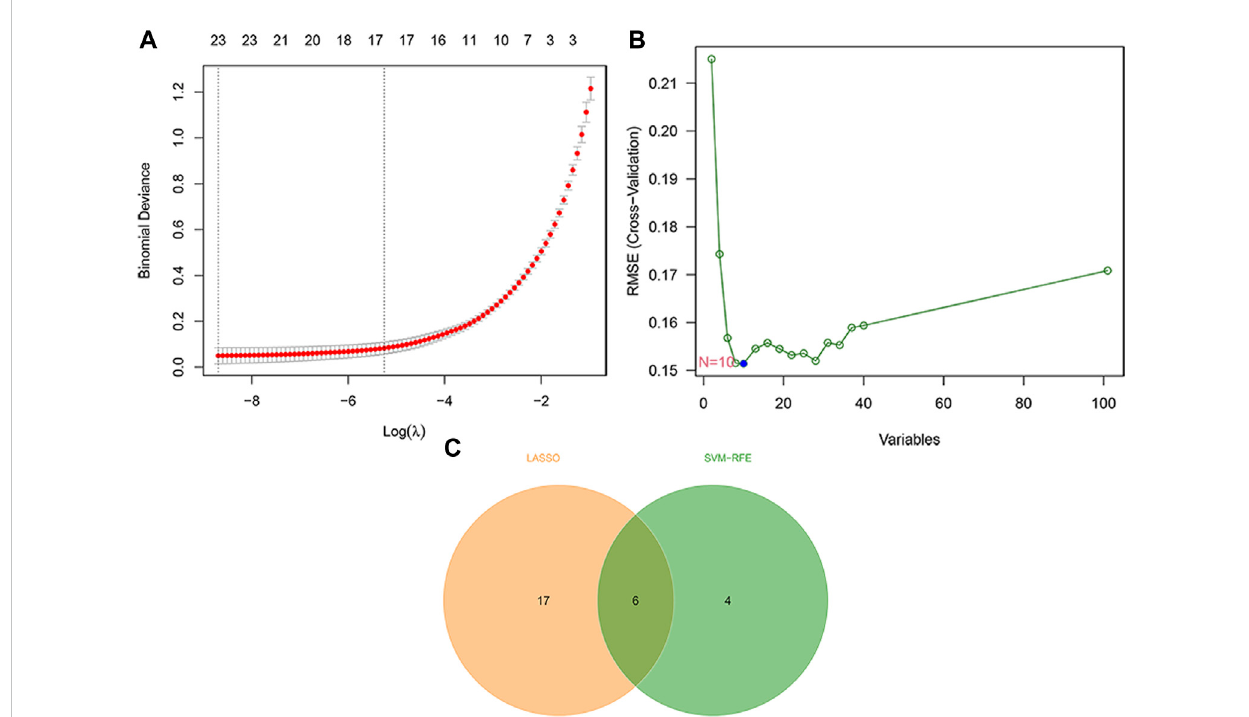
FIGURE 4 Identi fi cationofIPFkeyDEMRGsbyusingtwomachine-learningalgorithms. (A) Twenty-threegenesignatureswereextracted via LASSOregression. (B) Tengenesignatureswereextracted via SVM-RFE. (C) TheVenndiagramidenti fi edsixoverlappingDEMRGssharedbyLASSOandSVM-RFE.Therefore, the six overlapping DEMRGs were identi fi ed as key